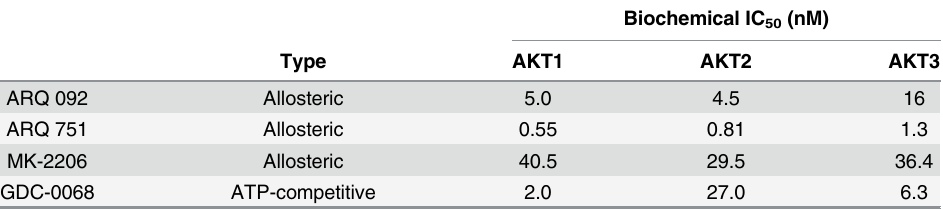
Table 1. ARQ 092 and ARQ 751